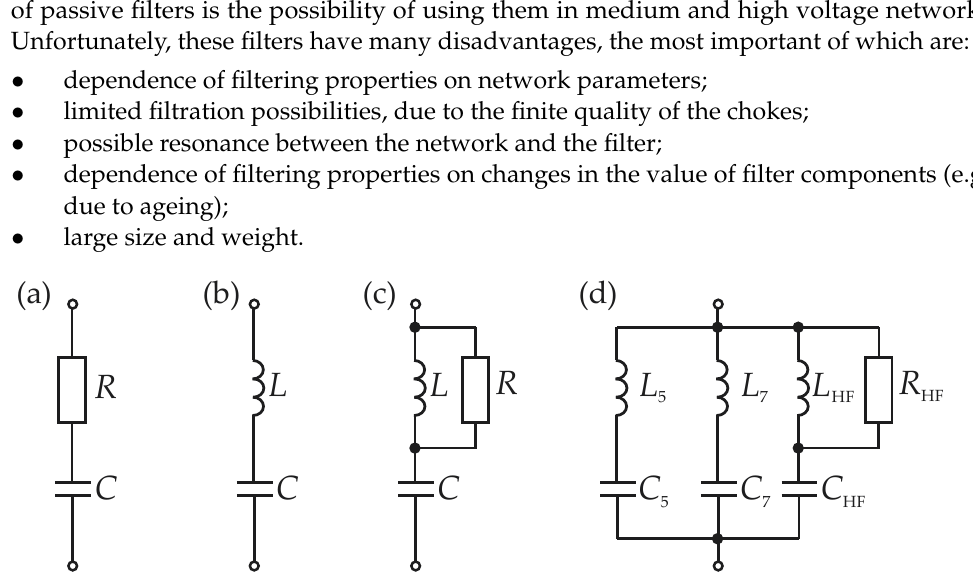
Figure 2. Basic branches of passive tuned filters: ( a ) first order filter, ( b ) second order filter, ( c ) second order damped filter, ( d ) filter combination for 5th, 7th and higher harmonics.